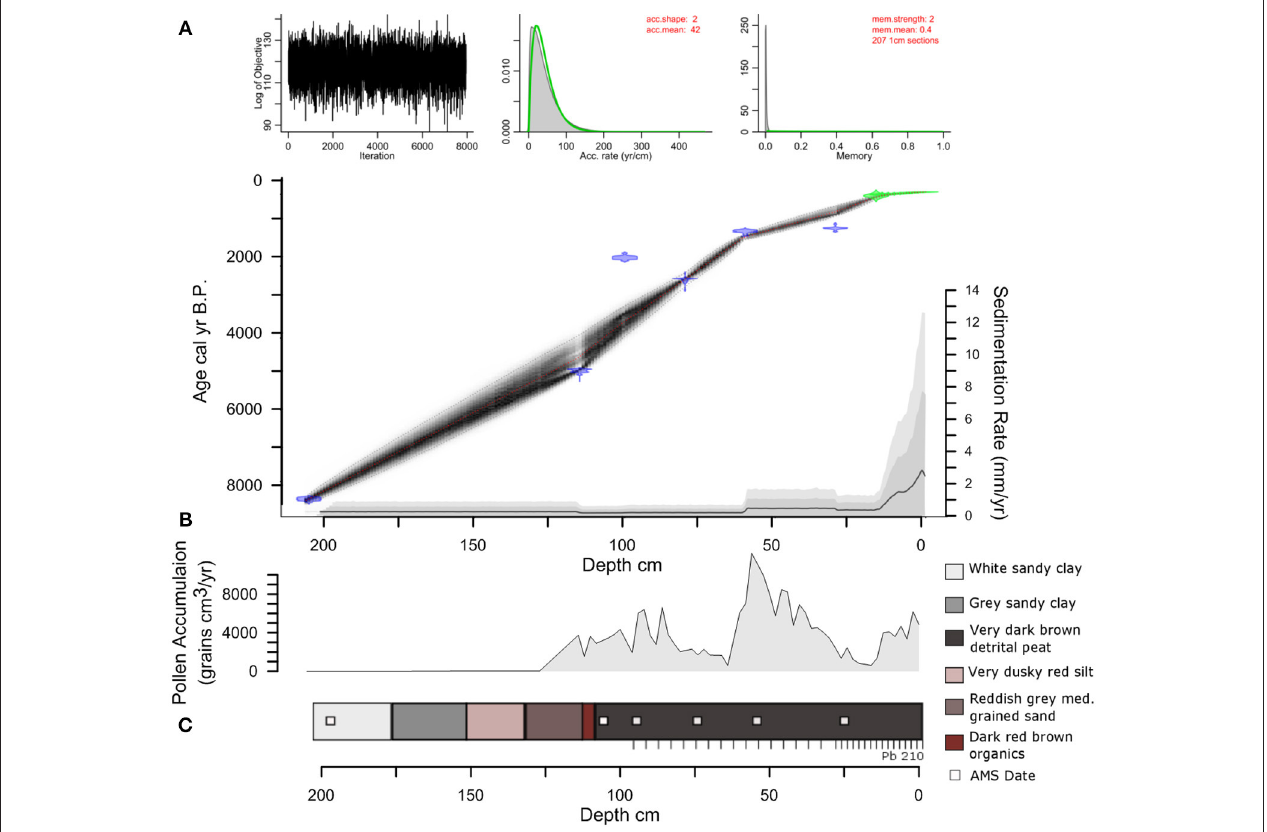
FIGURE 3 | Lago Caranã core lithology and Age model. (A) Age-depth model with MCMC iterations (top left) and priors (green curves) and posteriors (gray histograms) for accumulation rate (top middle) and memory (top right). The age model iterations (black hatching) are based on radiocarbon ages (blue pdfs) and 210 Pb ages (green pdfs), with model mean (red dashed) and 2 σ (black dashed) distributions. (B) Pollen Accumulation Rates from sediment core. (C) Sediment core lithology. AMS dates indicated by the white squares, 210 Pb indicated by tick marks. Low PAR prior to ∼ 4,700 cal yr B.P. is attributed to a combination of sandy sediments and low organics that likely reduced pollen